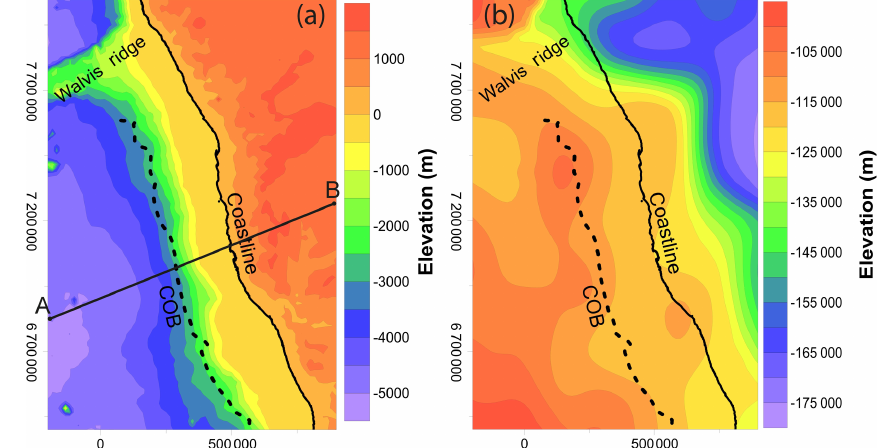
Figure 4. Surfaces with a fixed temperature for which the thermal boundary conditions were assigned in the SW African thermal model: (a) topography–bathymetry corresponding to the upper thermal boundary condition (5 ◦ C); (b) depth of the LAB utilized as the lower thermal boundary condition (1300 ◦ C).